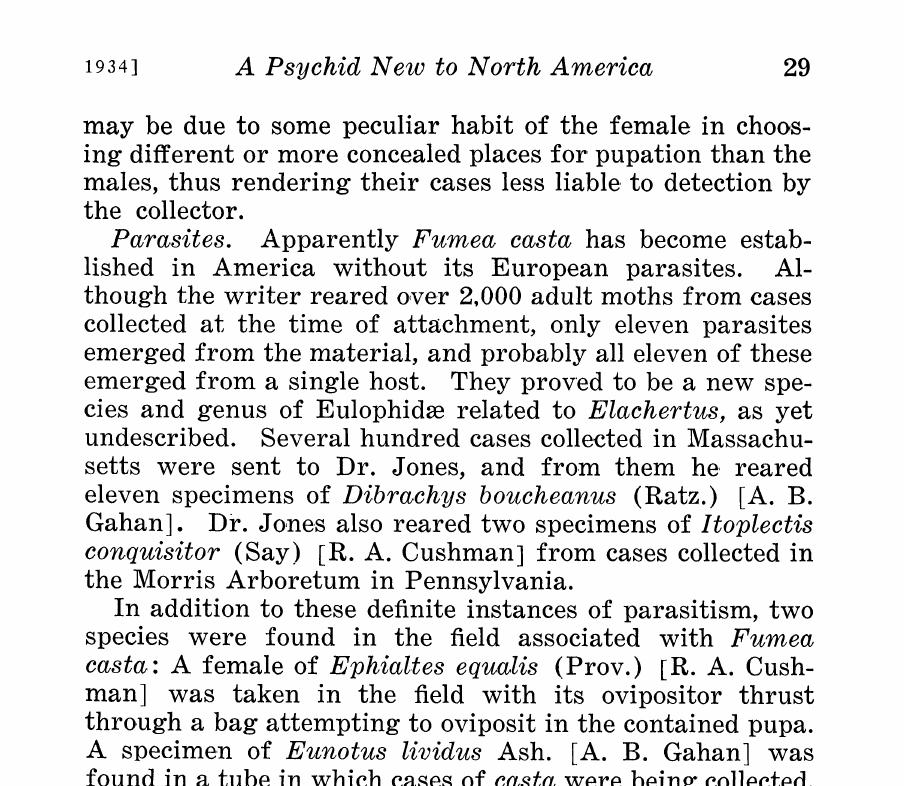
Fig. A.--Adult females on their bags (x2). Fig. B.--Adult emales (x2). Fig. C.--Adult males (x2//2). Fig. D.--Bags rom which adult males have emerged leav- ing their empty pupa-shells protrudifig from the bags (x2 /2). Fig. E.--Bags attached for pupation on a stone wall in a heavy infestation (V3 natural size). Fig. F.--Adult males